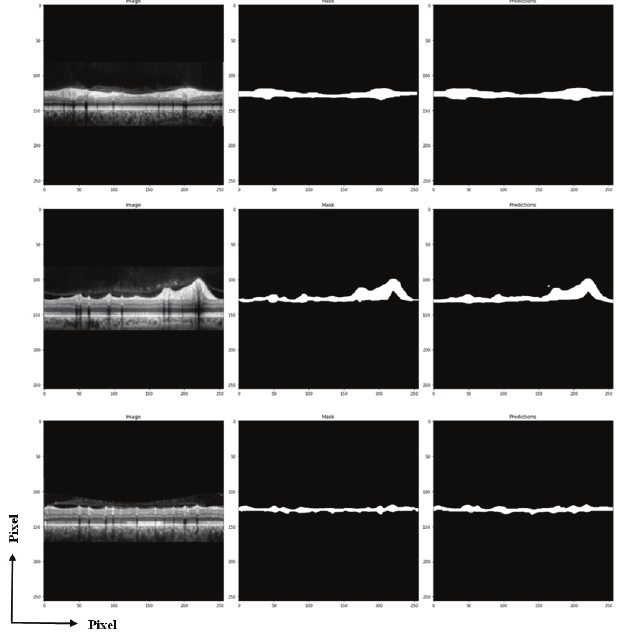
Figure 4. U-net output on validation data. Original image, manually segmented image, and output image, in that order.